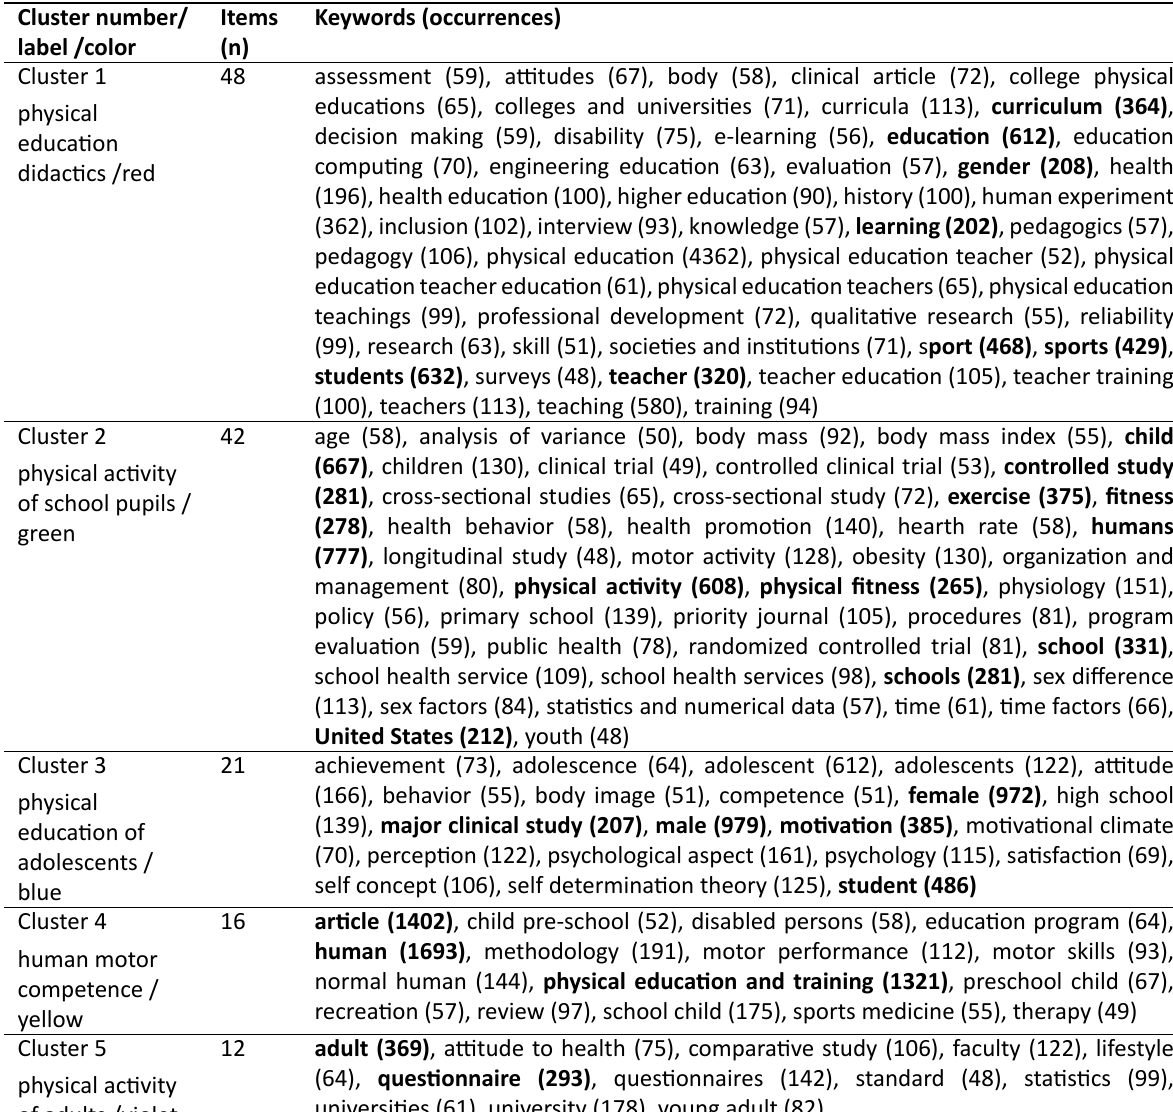
Table 4. Clusters of high-frequency keywords related to research on physical education Cluster number/ label